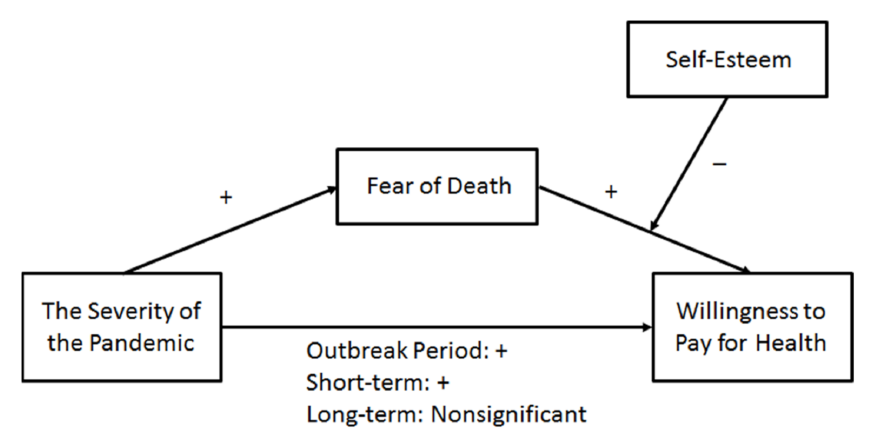
Figure 1. Theoretical model. Note: + means a significant positive effect, —means a significant negative